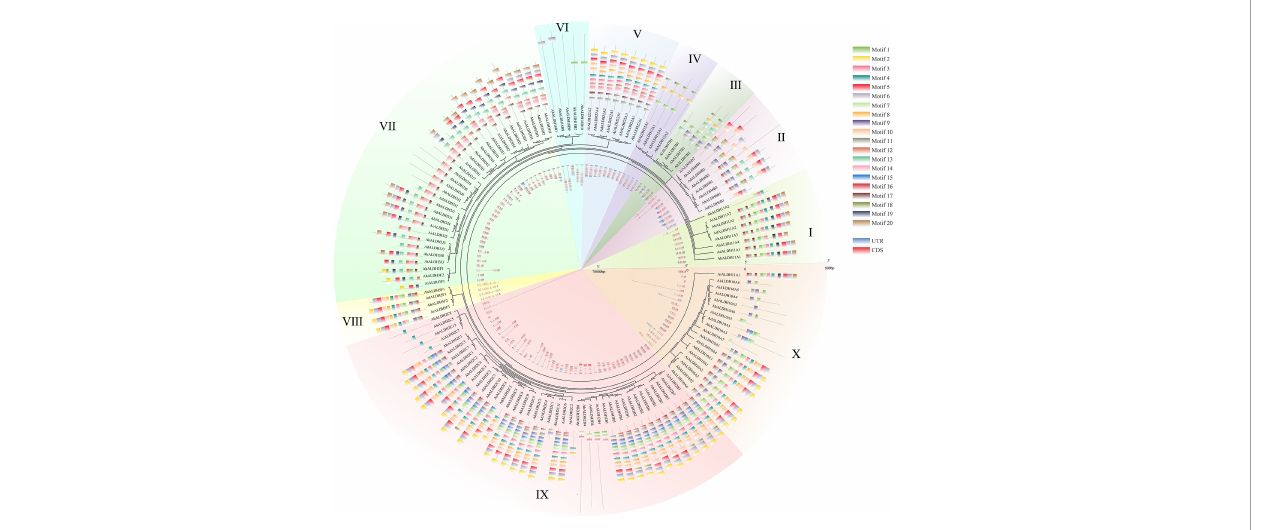
FIGURE 3 Motif and gene structure analysis of AhALDH members. The middle ring represents the evolutionary relationship of AhALDHs. The 10 families are highlighted with differently colored backgrounds. The outer ring shows the motif analysis of AhALDHs. Motifs from 1 to 20 are marked with differently colored boxes. The inner ring displays the gene structure analysis of AhALDHs. Blue boxes are untranslated regions (UTRs) and pink boxes are coding sequences (CDSs), black lines are the intron region.